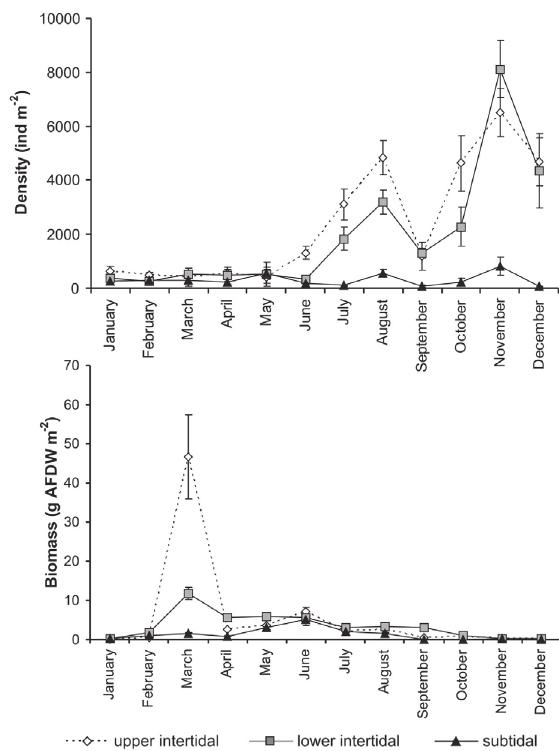
Fig . 2. – Spatial and seasonal density and biomass patterns (mean values with standard errors) of macroinvertebrates from the study